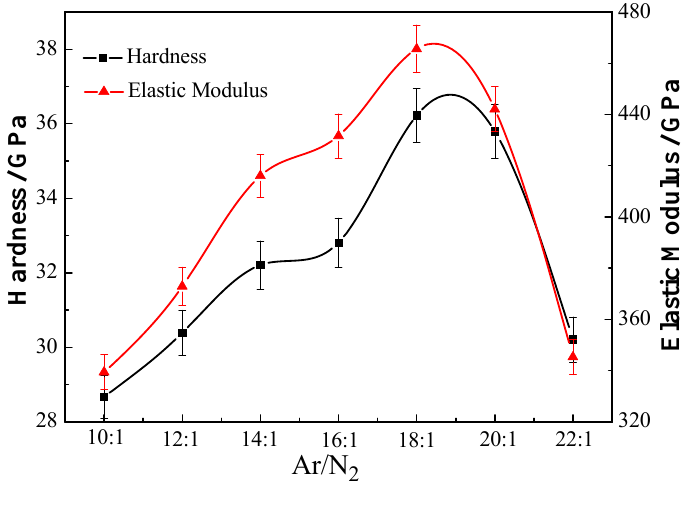
Figure 4. Hardness and elastic modulus of TiAlN/Al Ar/N 2